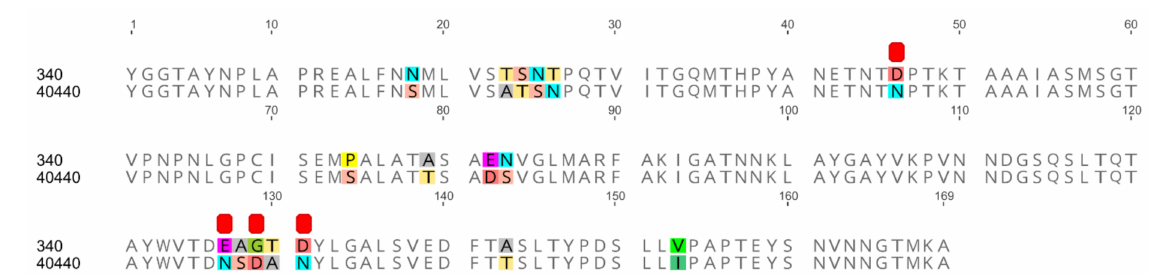
Figure 1. Amino acid alignment of hexon loop-1 sequences originating from two fowl adenovirus 5 strains: the reference strain 340 and another one (40440). The newly sequenced divergent strains are identical on the amino acid level to strain 40440 on this stretch. Differences are highlighted; furthermore, amino acid substitutions affecting the electrostatic charge of the protein are denoted using red